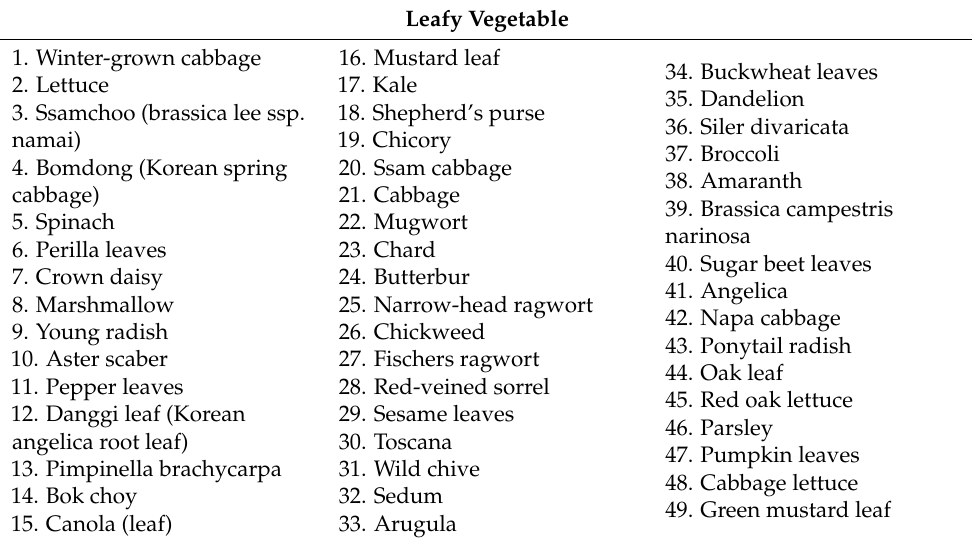
Table 1. The sampling plan consisted of two main parts. The first part involved sam- pling the incoming wholesale market before the produce was distributed in Gwangju Metropolitan City. The samples analyzed under the government surveillance program (The Health and Environment Research Institute under the Gwangju Metropolitan Government) were collected mainly from the two largest Gwangju area wholesale markets in Gwangju Metropolitan City and Chonnam Province from 2005 to 2019. The second part involved the sampling of leafy vegetables distributed in large or small local markets in Gwangju Metropolitan City. Most of the leafy vegetables consumed and distributed in South Korea were selected, and samples were collected. Whole samples were successfully analyzed within 24 h after collection. Table 1. The scope of 49 types of leafy vegetables analyzed in our